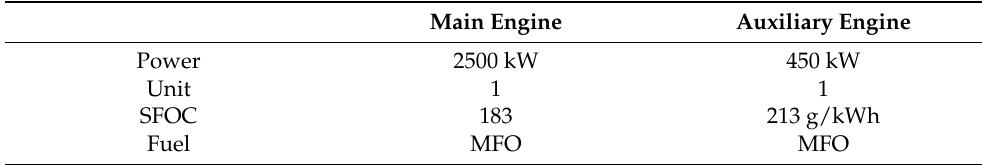
Table 3. Engine Table 3. Engine information.